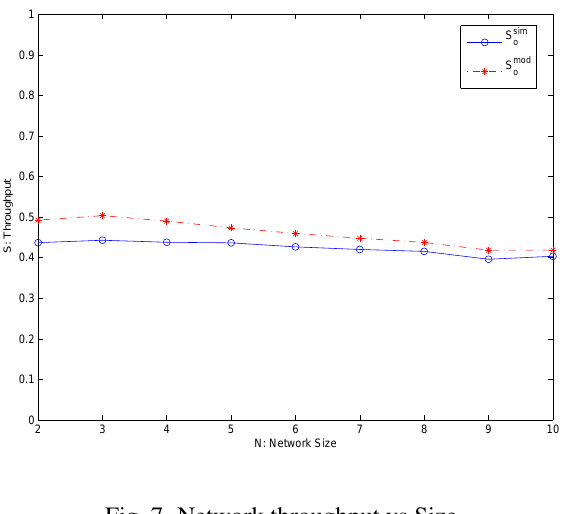
Fig. 7. Network throughput vs Size